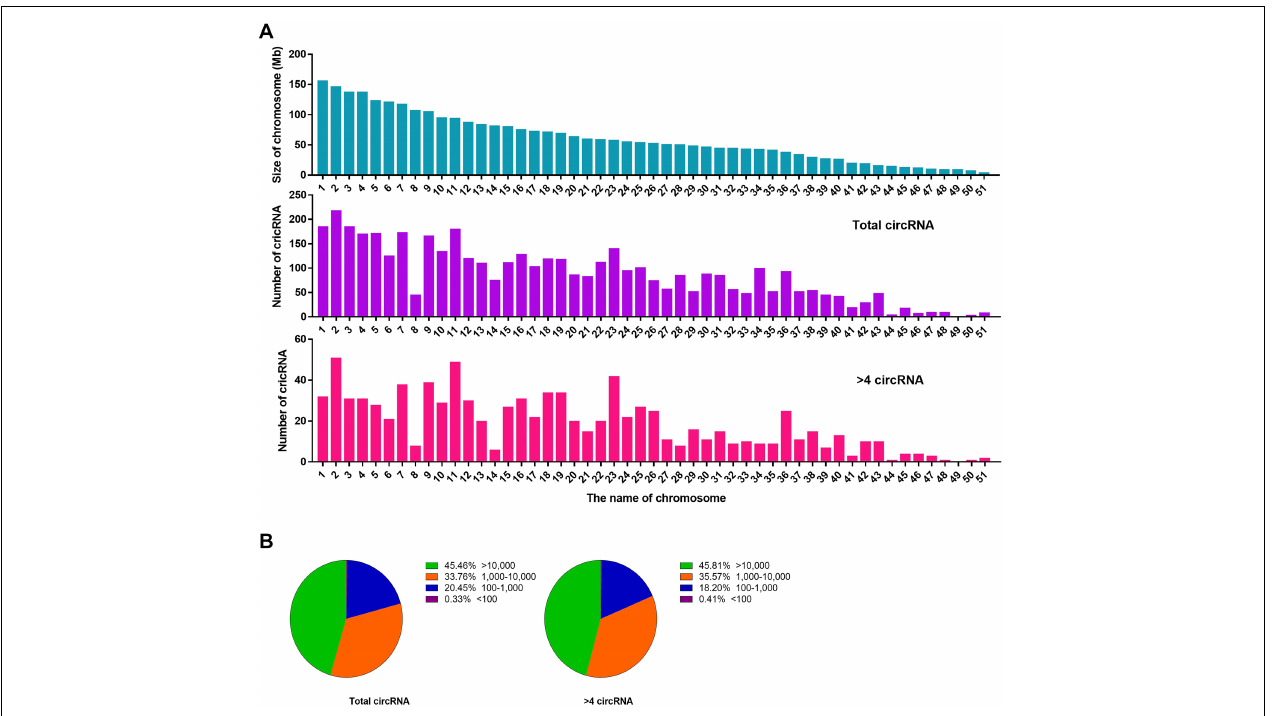
FIGURE 3 | Statistics of circRNAs distribution and length. (A) Size of chromosomes in C. plagiosum (blue column) and the number of circRNAs that matched on the chromosomes (purple column represents total circRNAs; pink column represents BSj reads > 4 circRNAs). (B) Statistics of the length of total circRNAs and BSj reads > 4 circRNAs; The first pie chart shows the proportion of circular RNA from 100 to 10,000 bp in all circular RNAs; The second pie chart shows the distribution of circular RNA length from 100 to 10,000 bp in all circular RNAs with BSj greater than 4. TABLE 3 | Information on eight circRNAs with high BSj reads. CricRNA ID Number of BSj